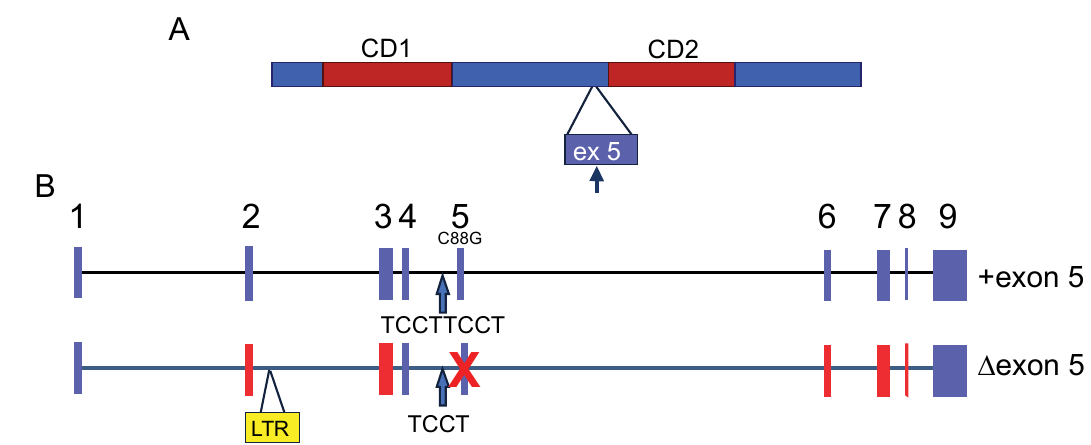
Figure 1. Mouse APOBEC3. ( A ) Diagram of mAPOBEC3 protein. CD1 encodes the deaminase activity and CD2 is required for packaging into virions. Exon 5 (ex5) is found in proteins made in certain inbred mouse strains. The black arrow points to the possible viral protease (PR) cleavage site in exon 5. ( B ) Diagram of the intron / exon structure of the two common m Apobec3 alleles. Red exons denote polymorphic coding regions. Blue arrows point to the polymorphism at the end of intron 4 that likely influences retention ( + exon 5) or skipping ( ∆ exon 5) of the 5th exon. See text for other details. Abbreviations: CD, cytidine deaminase domain; LTR, long terminal repeat.